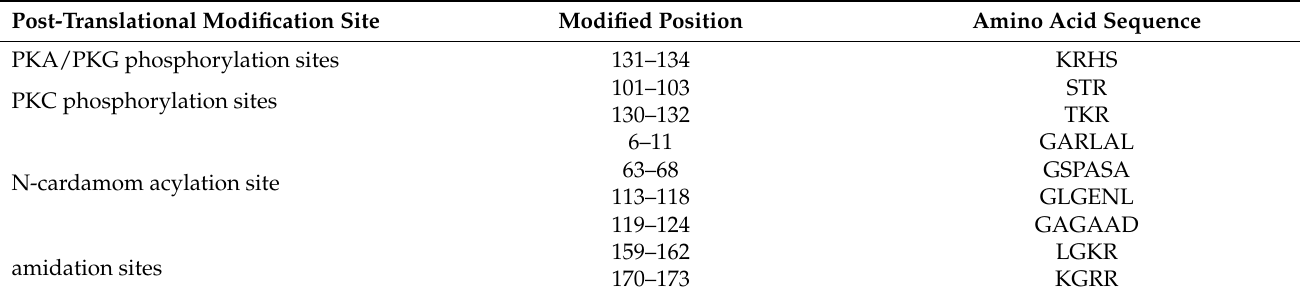
Table 1. Post-translational modification site of PACAP.